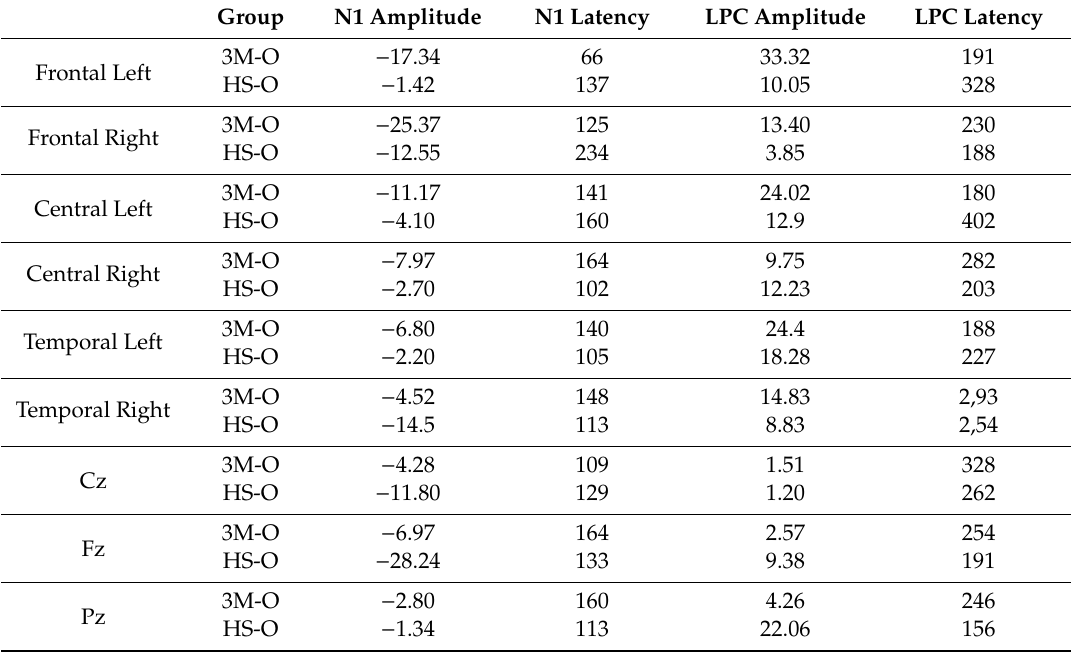
Table 1. Results of descriptive analysis of amplitude ( µ V) and latency (ms) of N1 and Late Positive Component (LPC) in 18-month-old 3M-O and HS-O subjects.